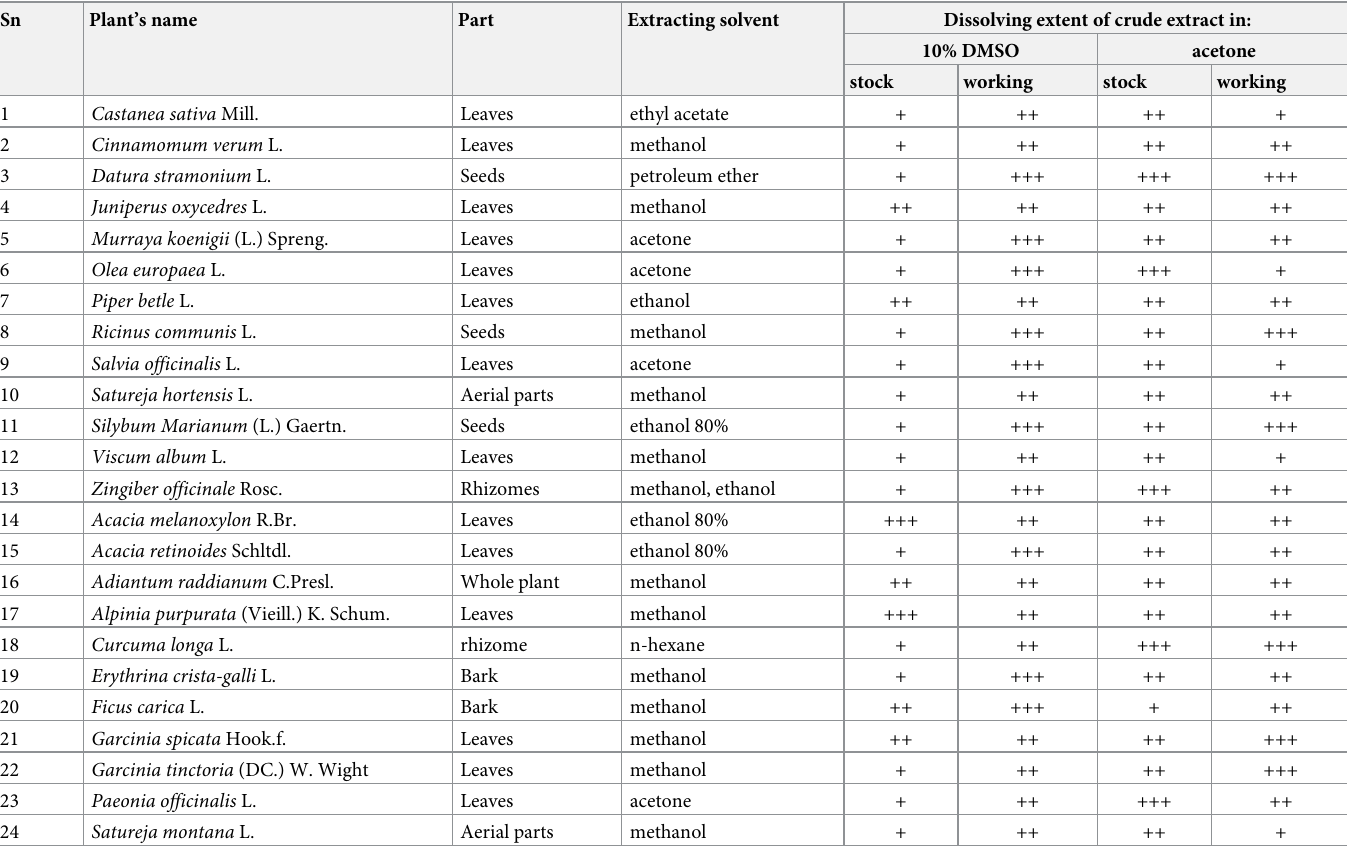
Table 4. Semi-quantitative evaluation of solubility of crude extracts in 10% DMSO and acetone. Sn Plant’s name